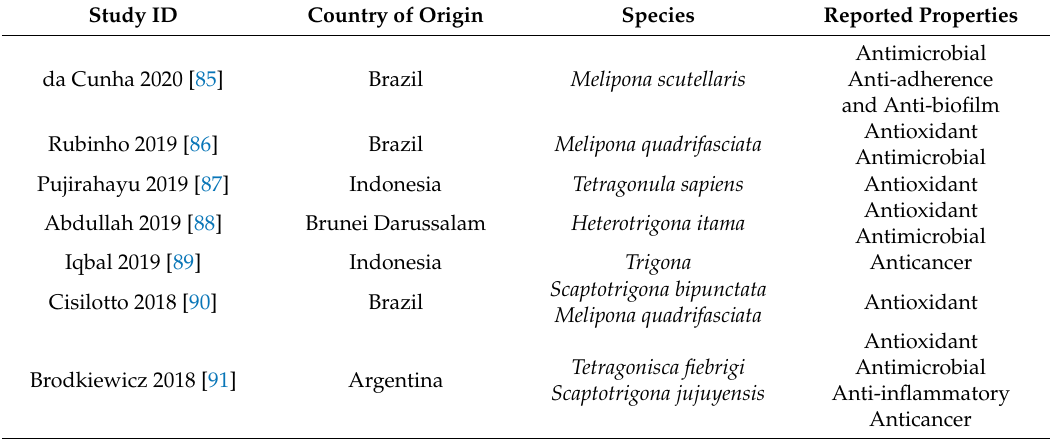
Table 2. List of studies on the potential medicinal properties of Stingless Bee Propolis